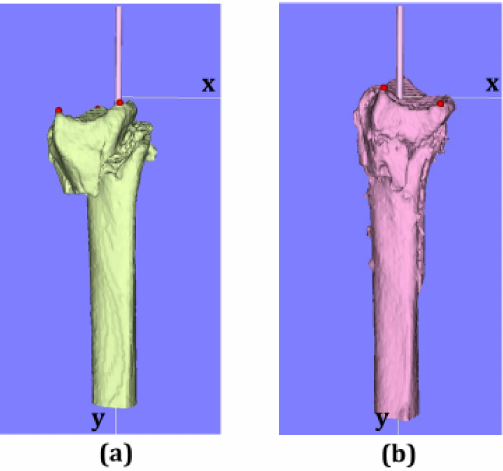
Figure 3. Sagittal view of 3D images. ( a ) Preoperative image, ( b ) postoperative